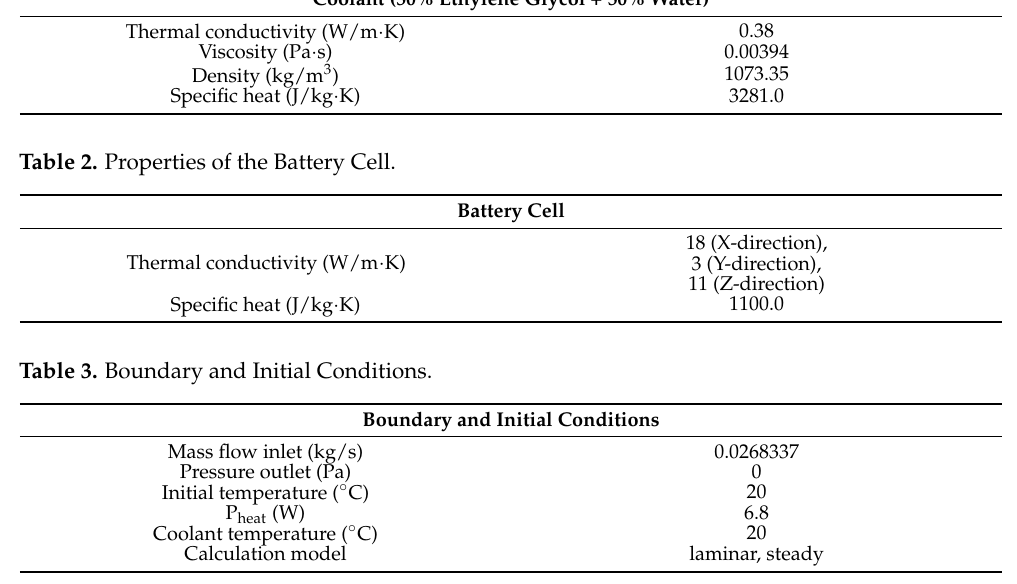
Table 2. Properties of the Battery Cell.